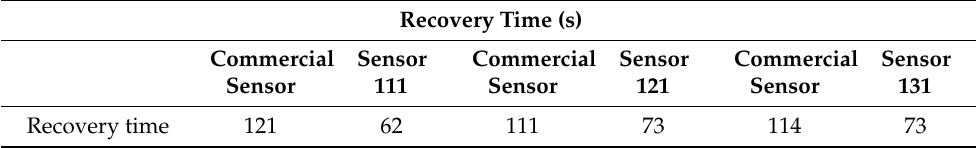
Table 2. Comparison between recovery time for the developed sensors and the commercial